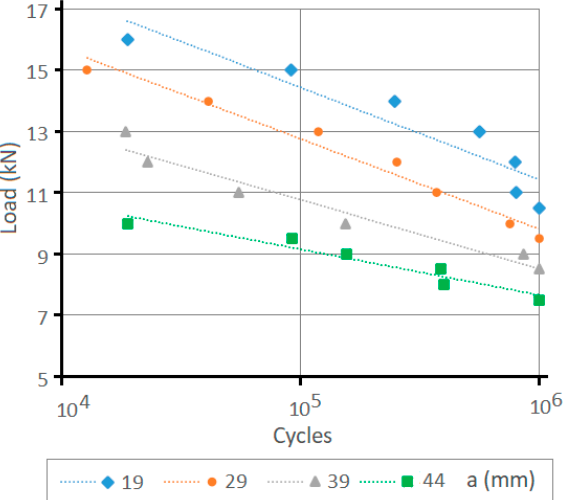
Figure 9. Result of the number of life cycles reached in the laboratory as a function of the front clamp lever ( a ) and as a function of the load ( L ) applied to the joint. The fatigue test is stopped whenever the number of load cycles reaches a value of 10 6 without the specimen breaking.